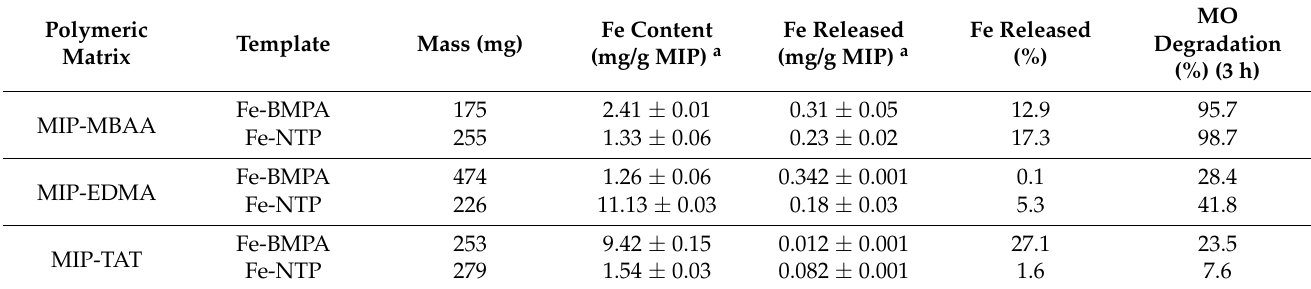
Table 2. Mass, total iron content, total iron leaching, and MO degradation efficiency of the Fe(III)-complex-imprinted polymers. Polymeric